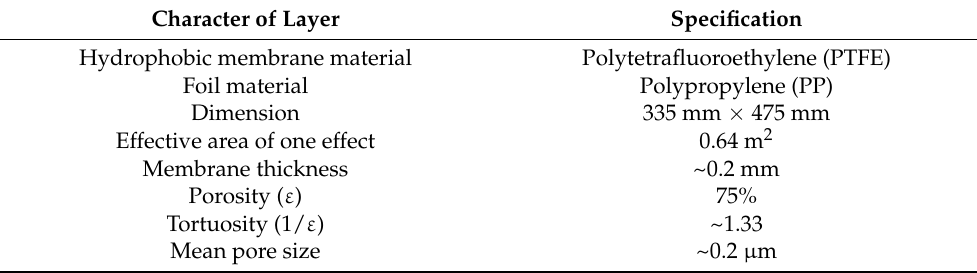
Figure 1. Photographs of the V-MEMD system facilities. ( A ) Thermal storage tank, ( B ) multiple effects, ( C ) HX-2, ( D ) HX-1, and ( E ) heat pump system. Table 1. Characteristics and specifications of the MD.